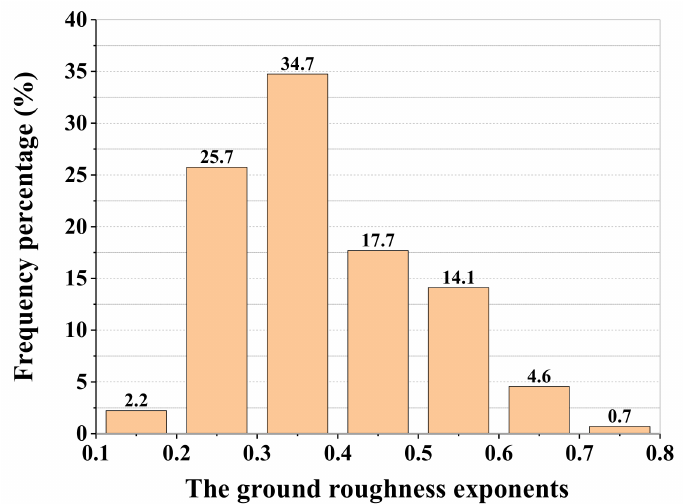
Figure 16. The distribution of the ground roughness